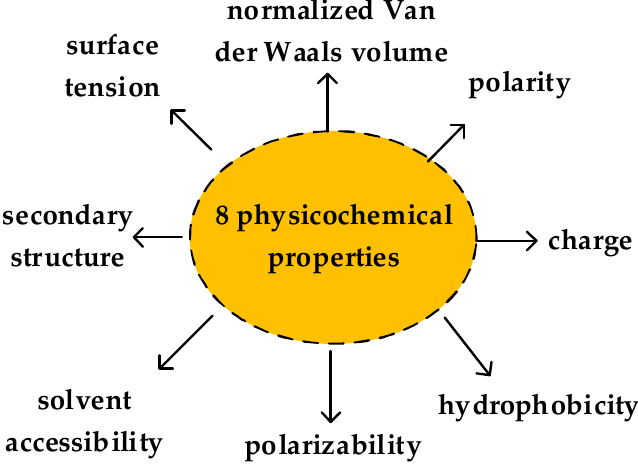
Figure 4. Eight physicochemical property attributes.